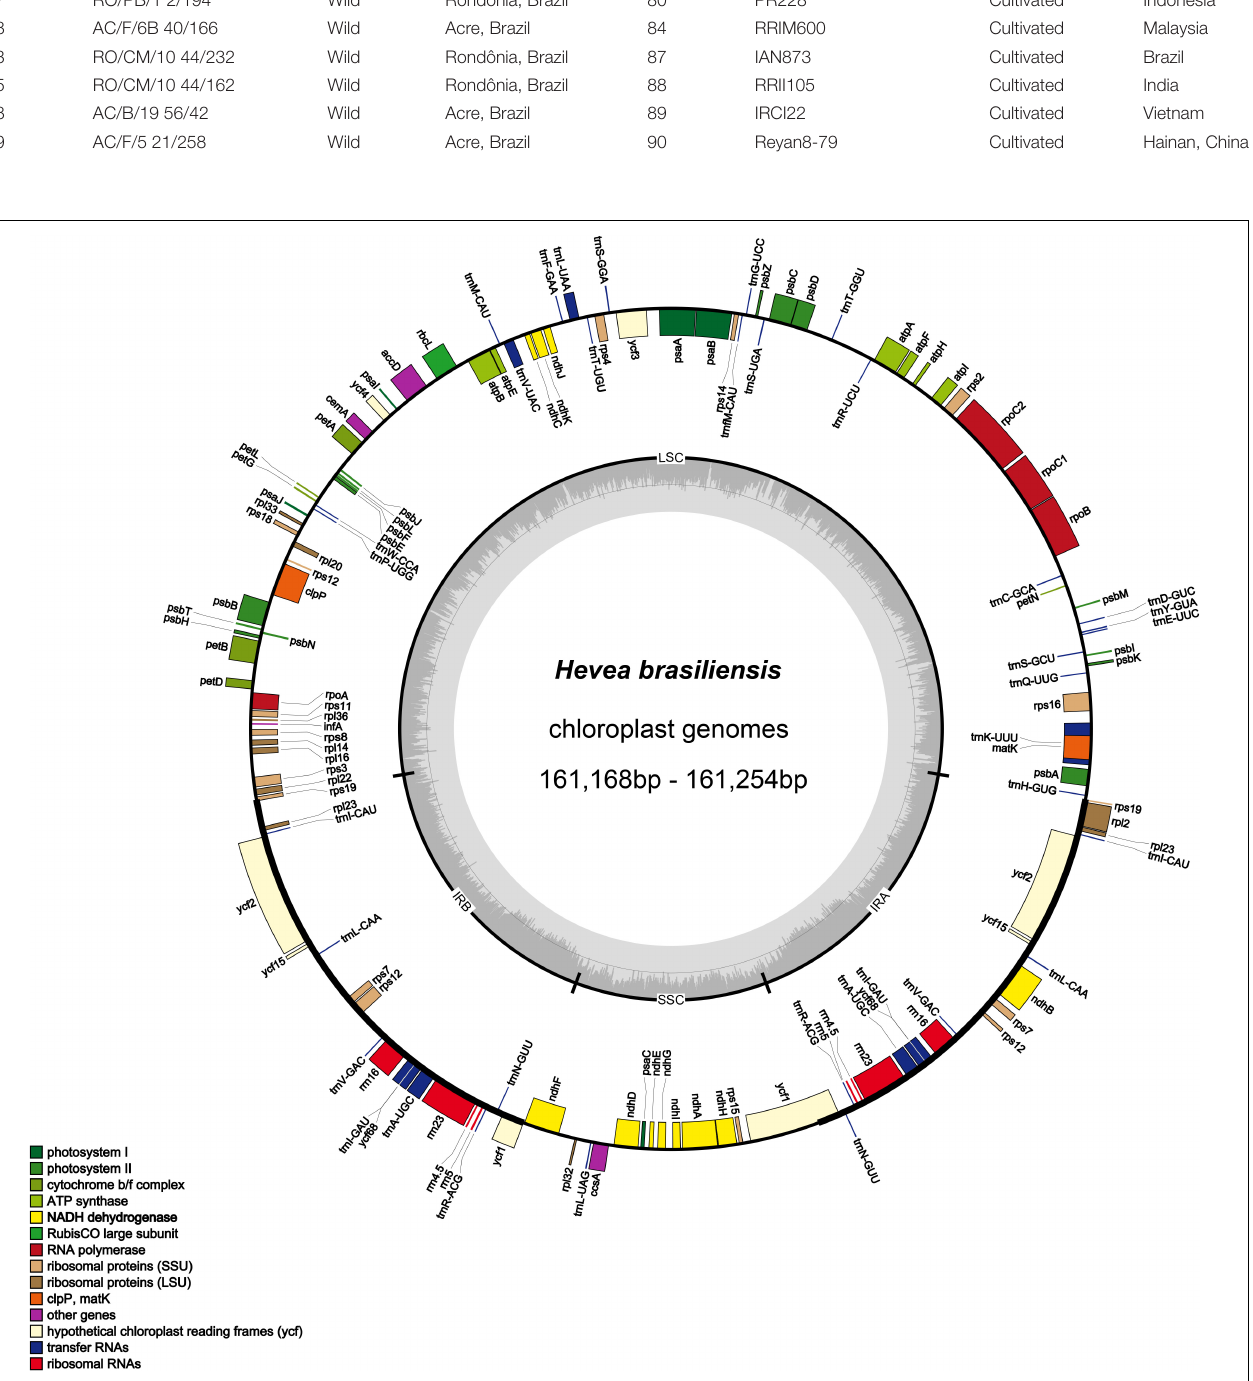
FIGURE 1 | Gene map of the H. brasiliensis chloroplast genomes. Genes lying outside of the outer circle are transcribed in the clockwise direction whereas genes inside are transcribed in the counterclockwise direction. Genes belonging to different functional groups are color-coded. Area dashed darker gray in the inner circle indicates GC content while the lighter gray corresponds to AT content of the genome.